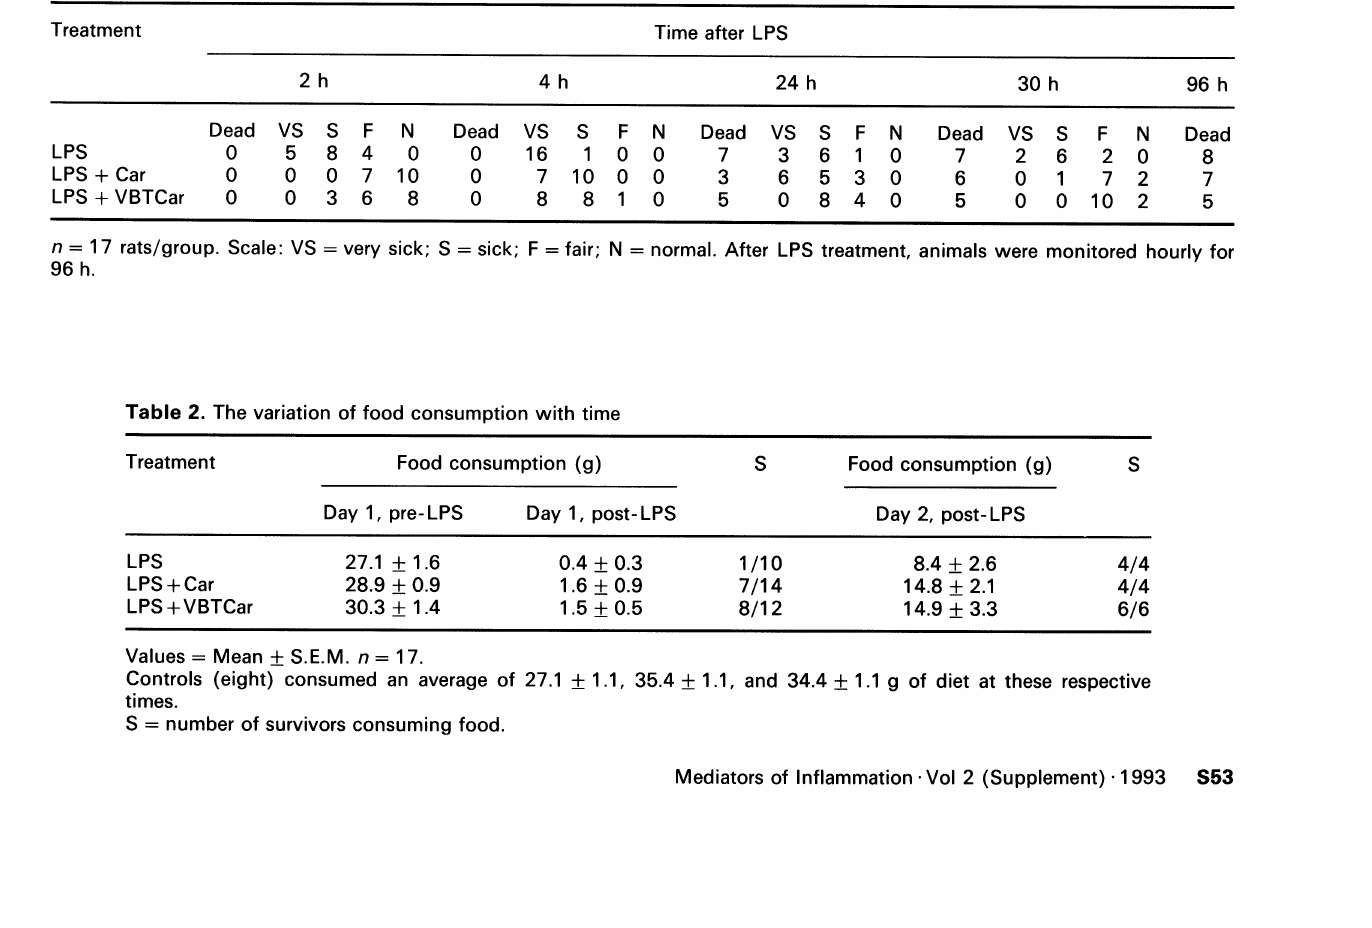
Table 1. The variation of survival and health with time after LPS Treatment